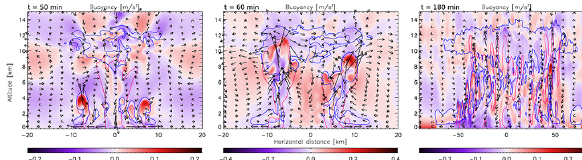
Fig. 6. Idealized simulation. Vertical cross section of buoyancy [ms − 2 ], at t = 50, 60 and 180min (from left to right). The environ- mental potential temperature lapse rate is increased by 10 = 5% with respect to the benchmark simulation, while all other initial pa- rameters are